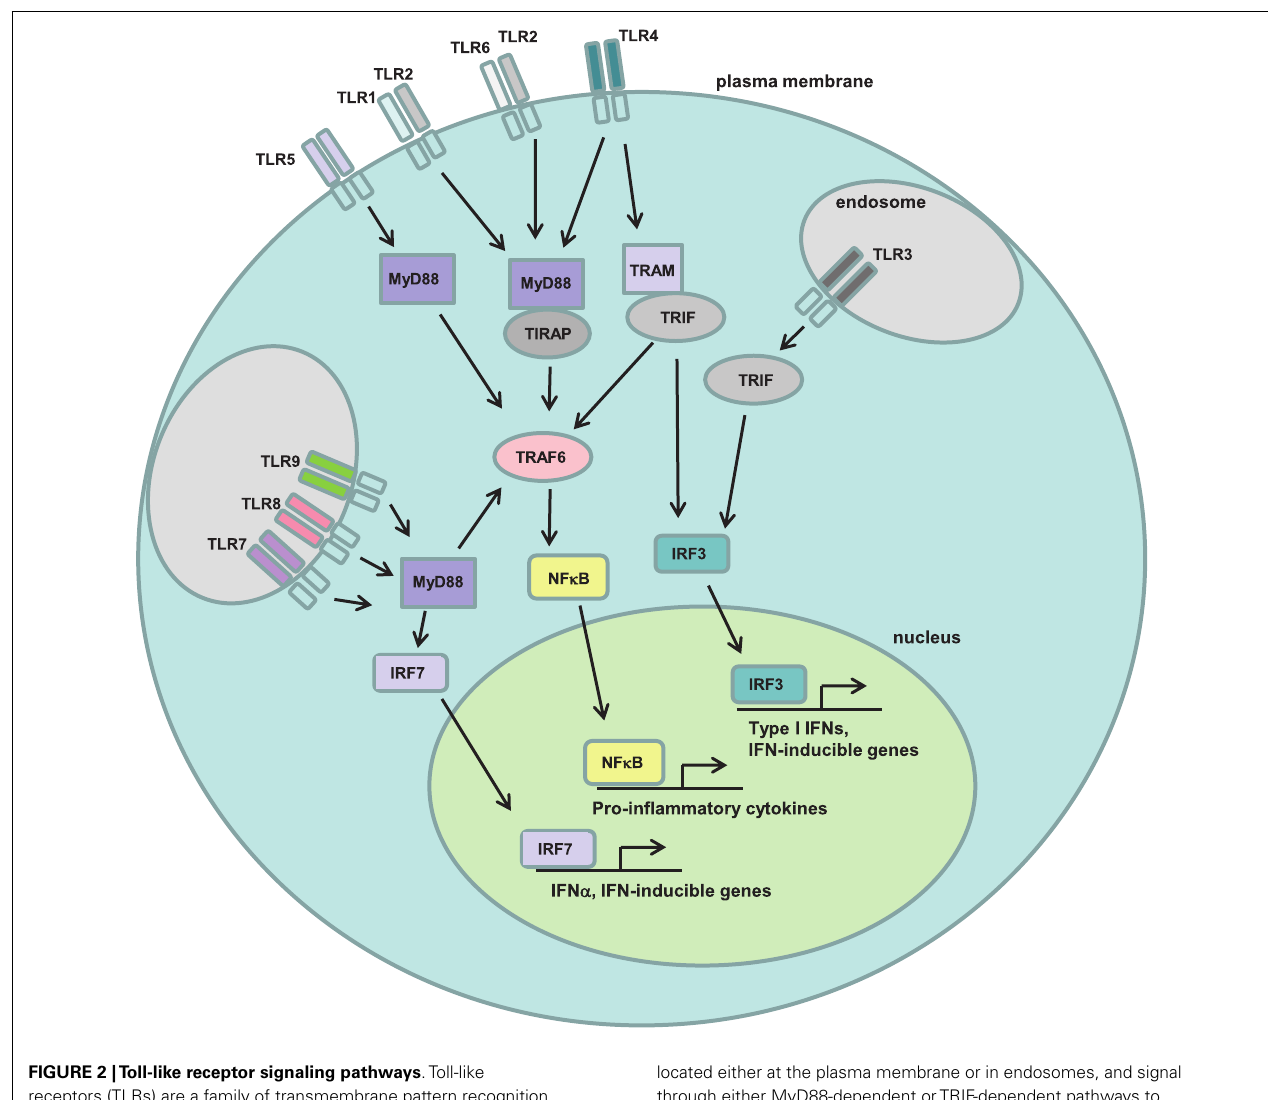
FIGURE 2 |Toll-like receptor signaling pathways .Toll-like receptors (TLRs) are a family of transmembrane pattern recognition receptors that recognize a wide variety of pathogen- and danger-associated molecular patterns (PAMPs/DAMPs).TLRs are